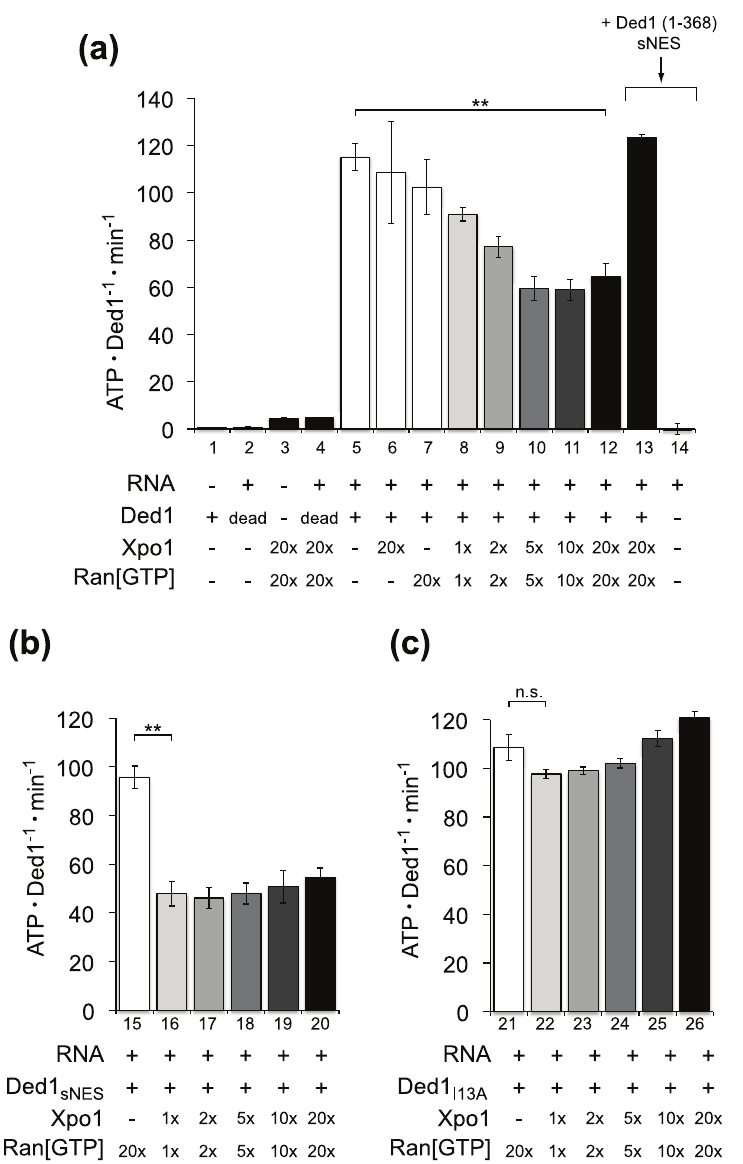
Fig 3. Xpo1 and Ran[GTP] reduce the ATPase activity of Ded1 in an NES-dependent manner. (a) The RNA-dependent ATPase activity of Ded1 is reduced in the presence of Xpo1/Ran[GTP]. The rates of ATP hydrolysis for either wildtype (+) or an ATPase-dead variant (Ded1 D306N ) of Ded1 (500 nM) in the presence or absence of yeast whole-cell RNA (320 μ g/mL), Xpo1 and/or Ran[GTP] Q71L , as indicated. The approximate molar ratios of Xpo1/Ran[GTP] Q71L relative to Ded1 are indicated, corresponding to Xpo1/Ran[GTP] Q71L concentrations of 0.55/0.65 μ M (1x), 1.1/1.3 μ M (2x), 2.75/3.25 μ M (5x), 5.5/6.5 μ M (10x), and 11/13 μ M (20x). The reaction shown in column 13 additionally contained Ded1(1 – 368) sNES (12.5 μ M), the truncated and ATPase-dead version of Ded1, which relieved inhibition by Xpo1 and Ran[GTP]. (b) A tight-binding NES reduced the amount of Xpo1 and Ran[GTP] required for maximal inhibition of Ded1 ATPase activity. RNA- stimulated ATPase activities of Ded1 sNES are shown in the absence (column 15) and presence (columns 16 – 20) of Xpo1 and Ran[GTP] Q71L . The concentrations of Xpo1 and Ran[GTP] Q71L are the same as those shown in columns 8 – 12 of (a). (c) Disrupting the NES of Ded1 with the I13A substitution prevents inhibition by Xpo1 and Ran[GTP]. RNA-stimulated ATPase activities of Ded1 I13A are shown in the absence (column 21) and presence (columns 22 – 26) of Xpo1 and Ran[GTP] Q71L . The concentrations of Xpo1 and Ran[GTP] Q71L are the same as those shown in columns 8 – 12 of (a). ** P < 0.0005; n.s., not